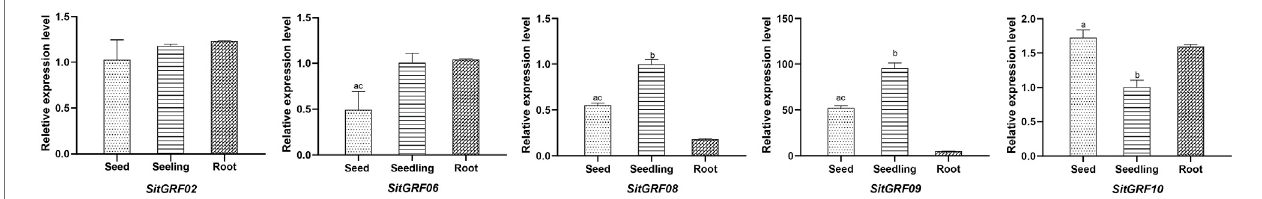
FIGURE 10| Tissue speci fi cexpression analysisof SitGRF genesin germinated seed, 2-week-old seedling, and root. The bars representthe mean values ofthree replicates ± s.d.Signi fi cantdifferencesinmeansareindicatedbya,b,c, p < 0.01,accordingtoone-wayANOVAtest.arepresentsthecomparationbetweengerminated seed and seedling. b represents the comparation between seedling and root. c represents the comparation between germinated seed and root.